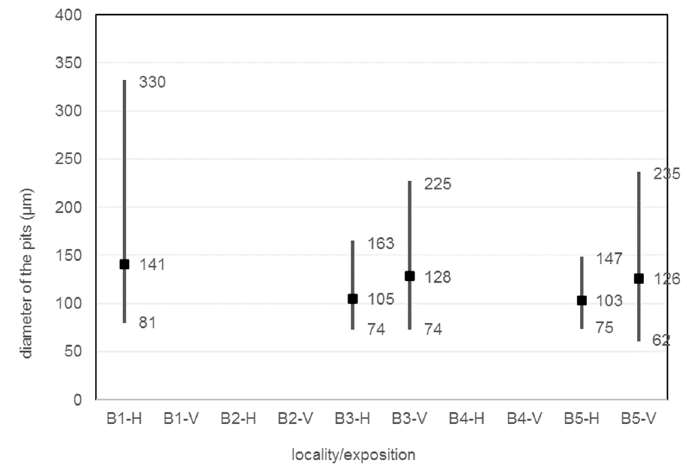
coupons analysed. The horizontal corrosion coupons from sites B3-H and B5-H show very similar average, minimum and maximum values of depth, diameter and number of pits. Figure 17. Diameter of the pits. Figure 17. Diameter of the pits.